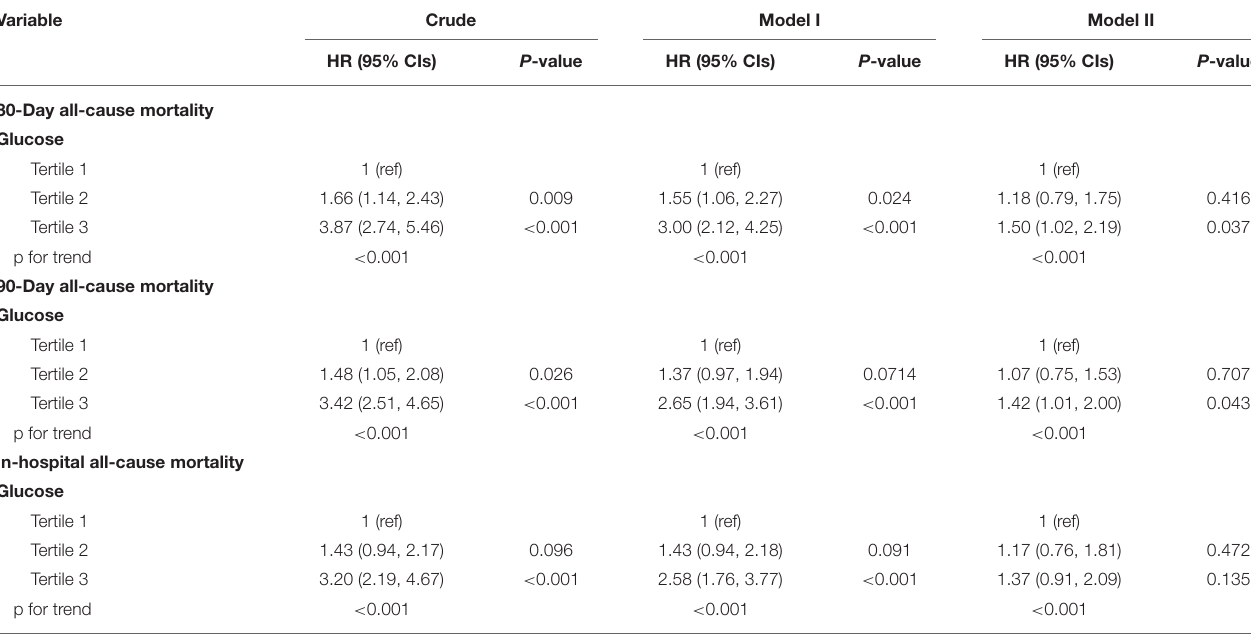
TABLE 2 | HRs (95% CIs) for all-cause mortality against admission blood glucose tertile.